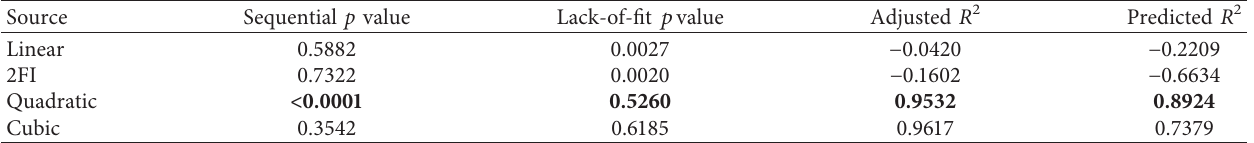
Table 3: Summary of fitting